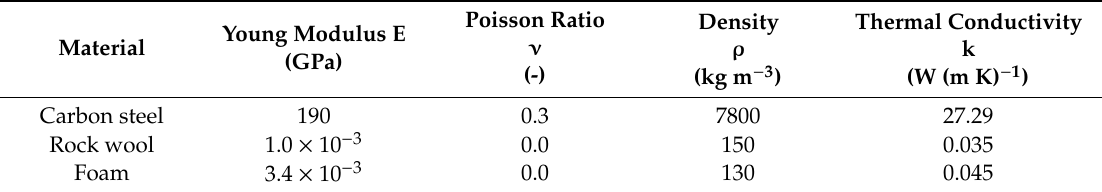
Table 1. Material properties at 20 ◦